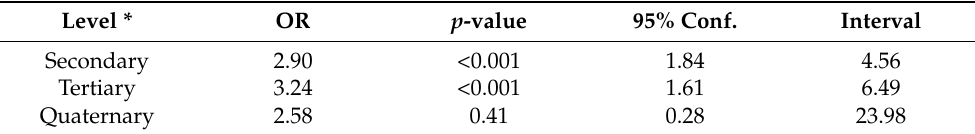
Table 6. Logistic Regression for the Likelihood of Asymptomatic Status by Viral Transmission Level.